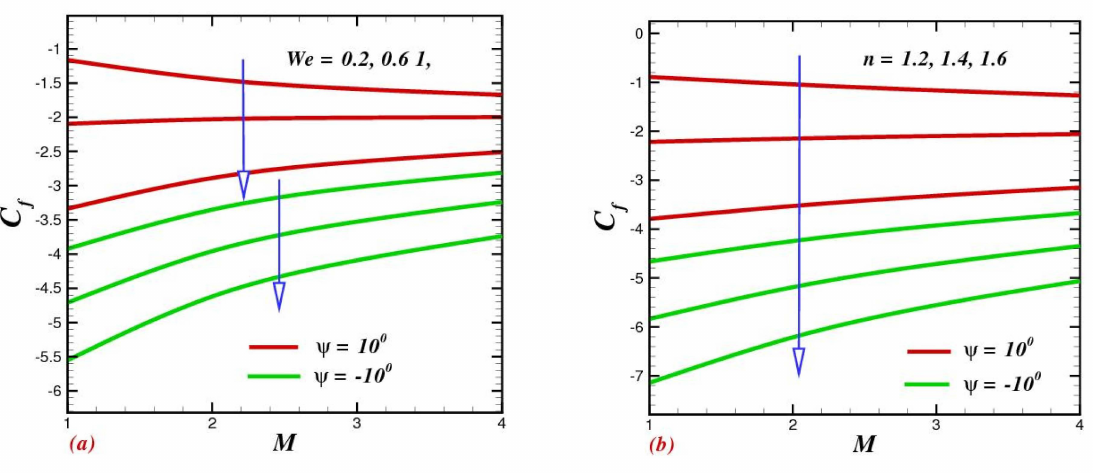
Figure 9. Impact of ( a ) the Weissenberg number We and ( b ) the power-indexed parameter n on skin friction C f .